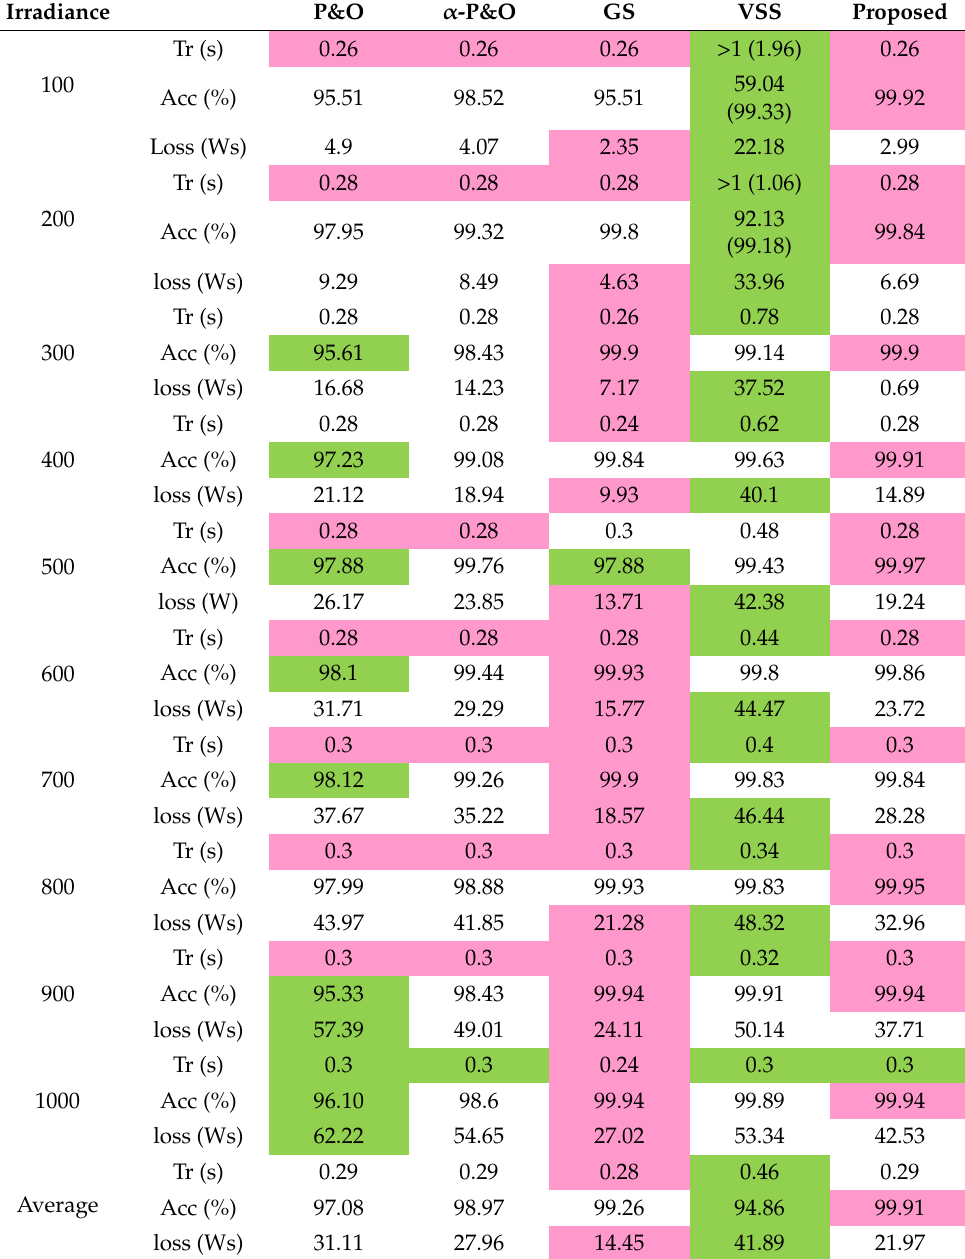
Table 3. Simulated results of five compared MPPT methods under uniform insolation